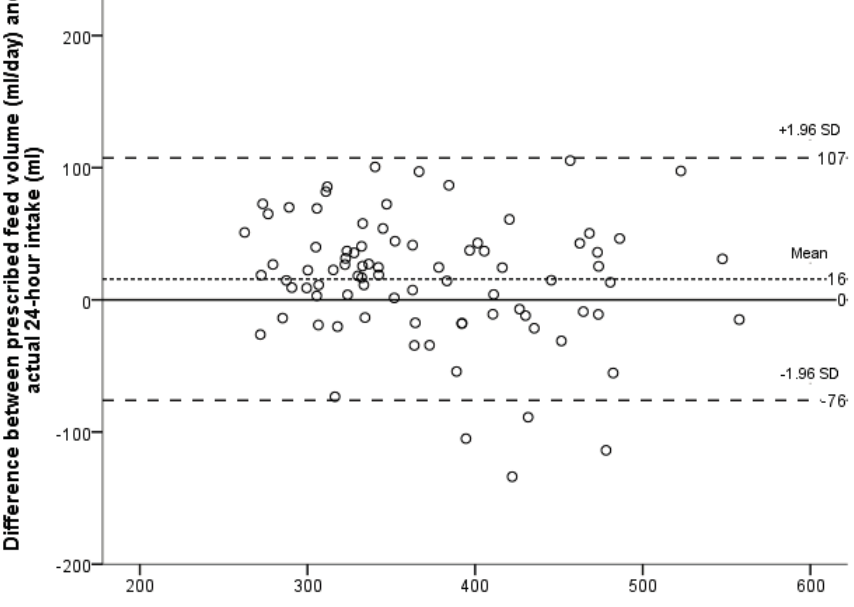
Figure 2. Bland-Altman plot of the agreement between the prescribed feed volume in mL/day and the actual intake of the infant for infants receiving ≤ 2 breastfeeds in 24 h. Each point represents one infant’s intake over 24 h for infants receiving ≤ 2 breastfeeds (N =